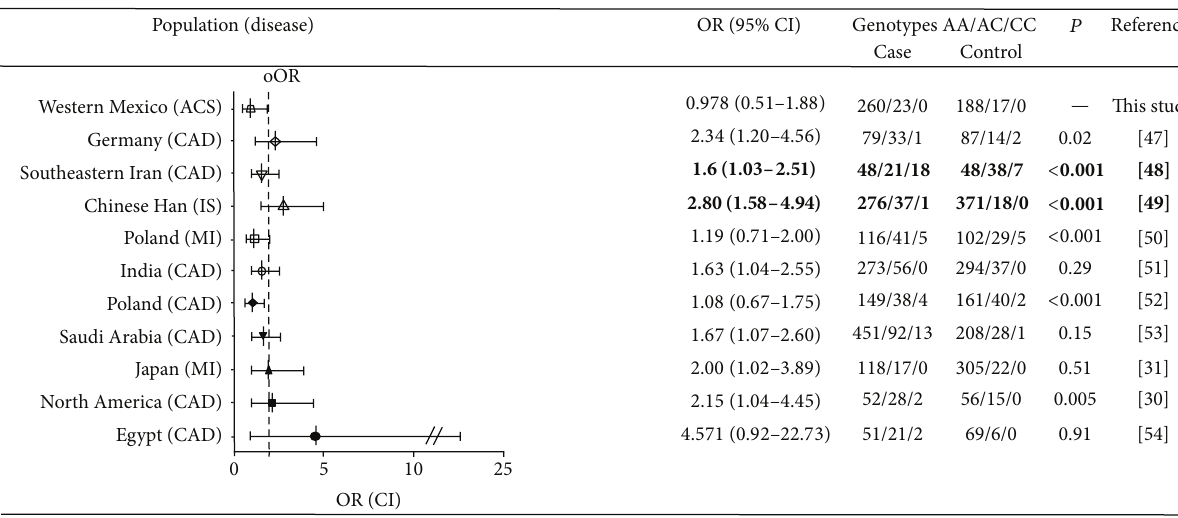
Figure 1: Forest plot of ORs for CAD, MI, and IS in the dominant model (CC + AC versus AA) of the SELE gene A561C polymorphism stratified by ethnicity. oOR: overall OR. Studies where genetic association was significant are highlighted in bold. 𝑃 values for population comparisons were evaluated in healthy subjects (control group). CAD: coronary artery disease; MI: myocardial infarction; IS: ischemic stroke.